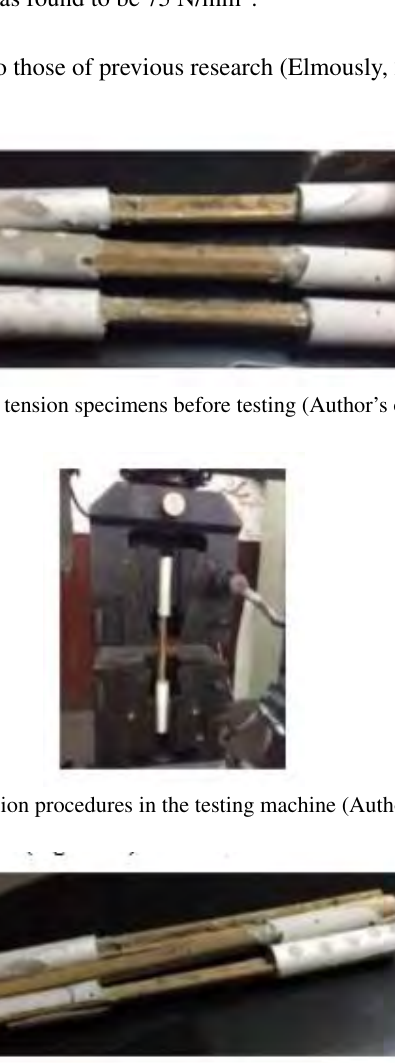
Figure 19. Longitudinal cracks in Epoxy and Specimen (Author’s own, n.d.)